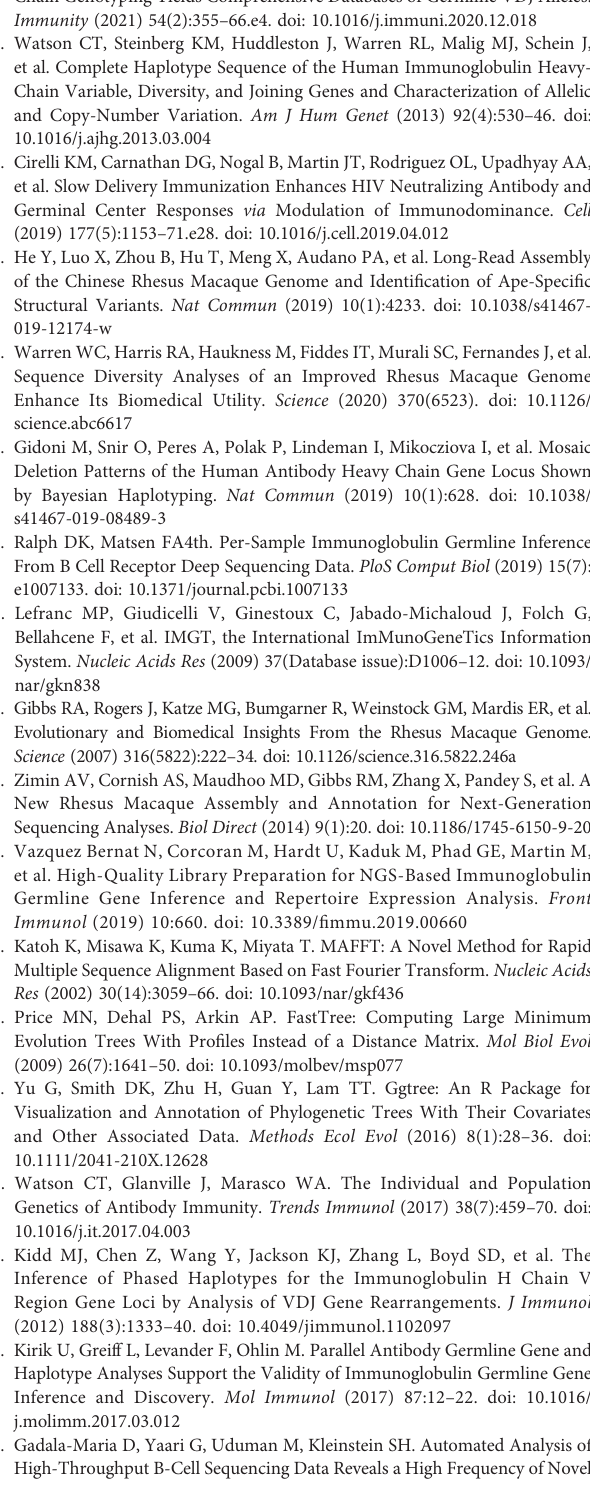
Supplementary Table 1 | Exact allele matches between KIMDB and IMGT. Supplementary Table 2 |